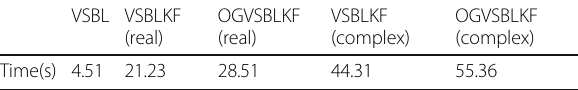
Table 2 Comparison of time cost for different